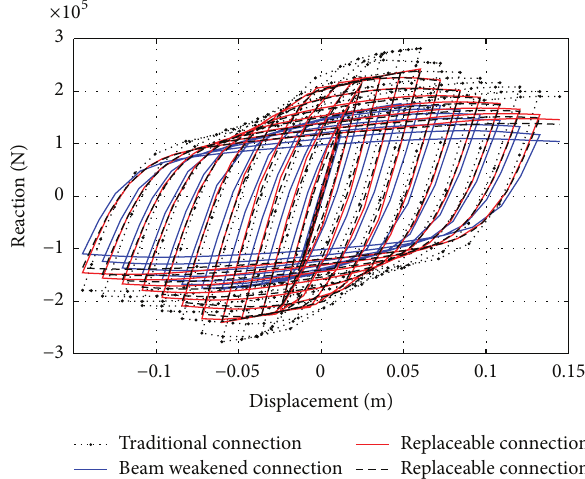
Figure 11: Hysteresis curves of different connections.